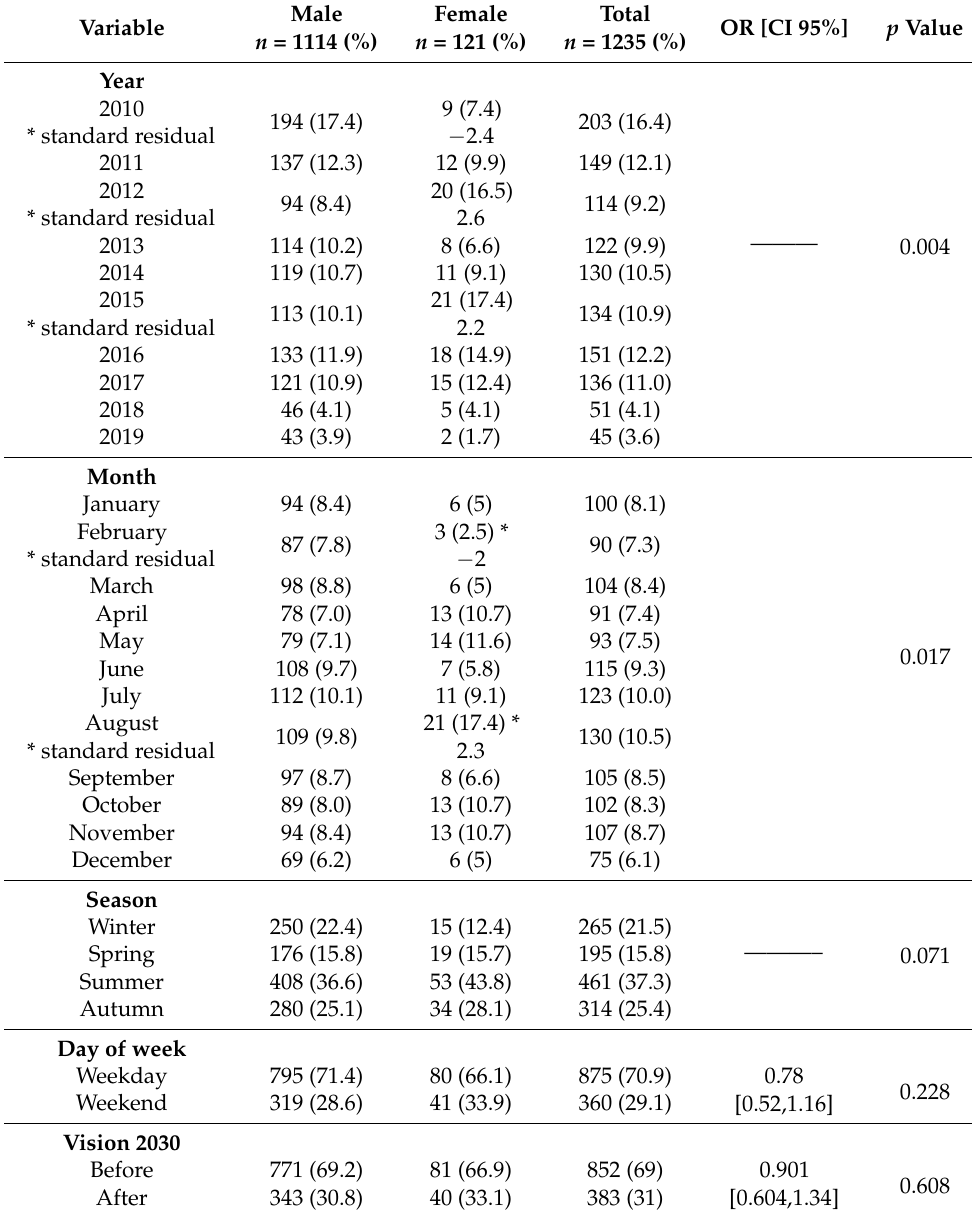
Table 1. Time trends and seasonal variation of traumatic head injury cases by gender ( n =